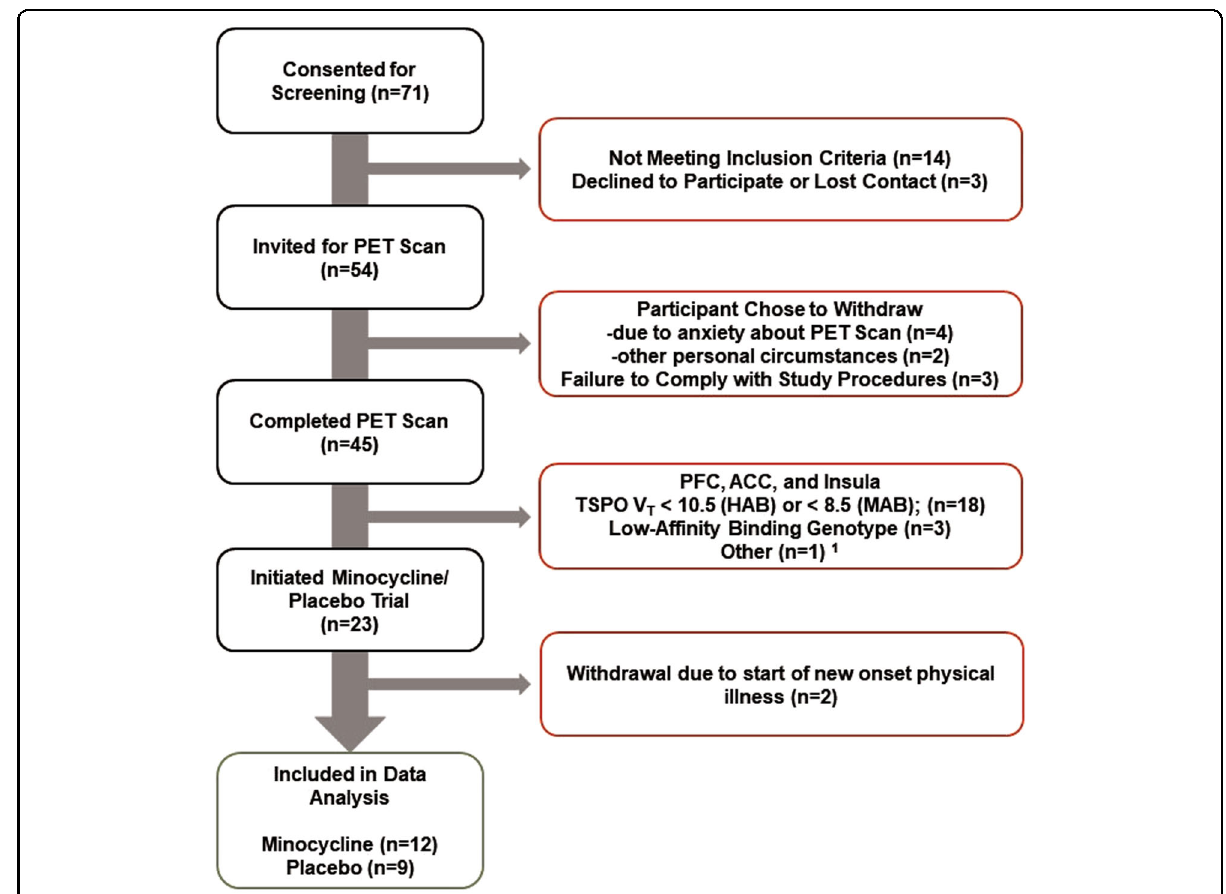
Fig. 1 Flow diagram of study participants. Flow of participants through the study. 1 Diagnosis reclassi fi ed as bipolar type II. ACC anterior cingulate cortex, PFC prefrontal cortex, PET positron emission tomography, TSPO V T translocator protein total distribution